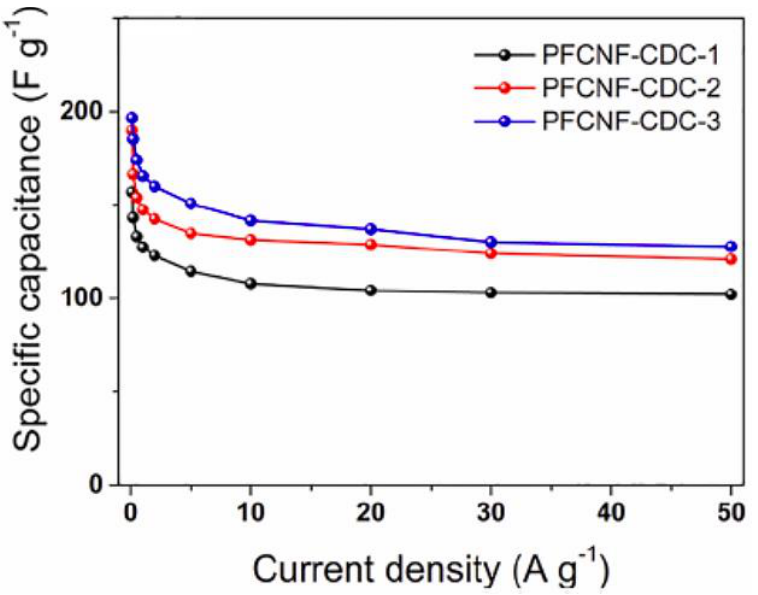
Figure 12. Specific capacitances of phenolic nanocomposite at different current densities [131]. PFCNF-CDC = phenolic resin/polyvinylpyrrolidone blend carbon nanofiber and carbide-derived carbon. Reproduced with permission from Elsevier.